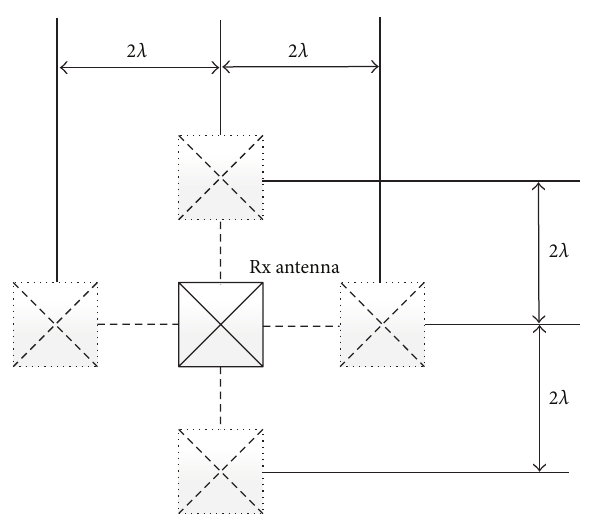
Figure 2: Layout of corridor A.